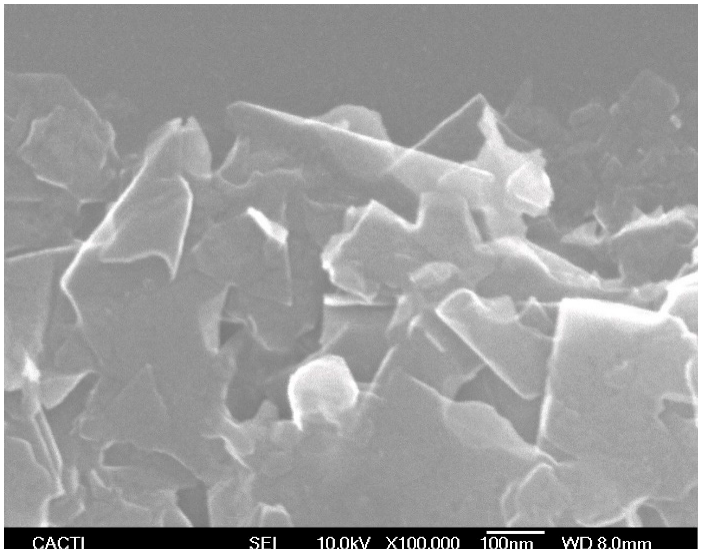
Figure 1. SEM image of P-GnP nanopowder at 100,000× magnification.